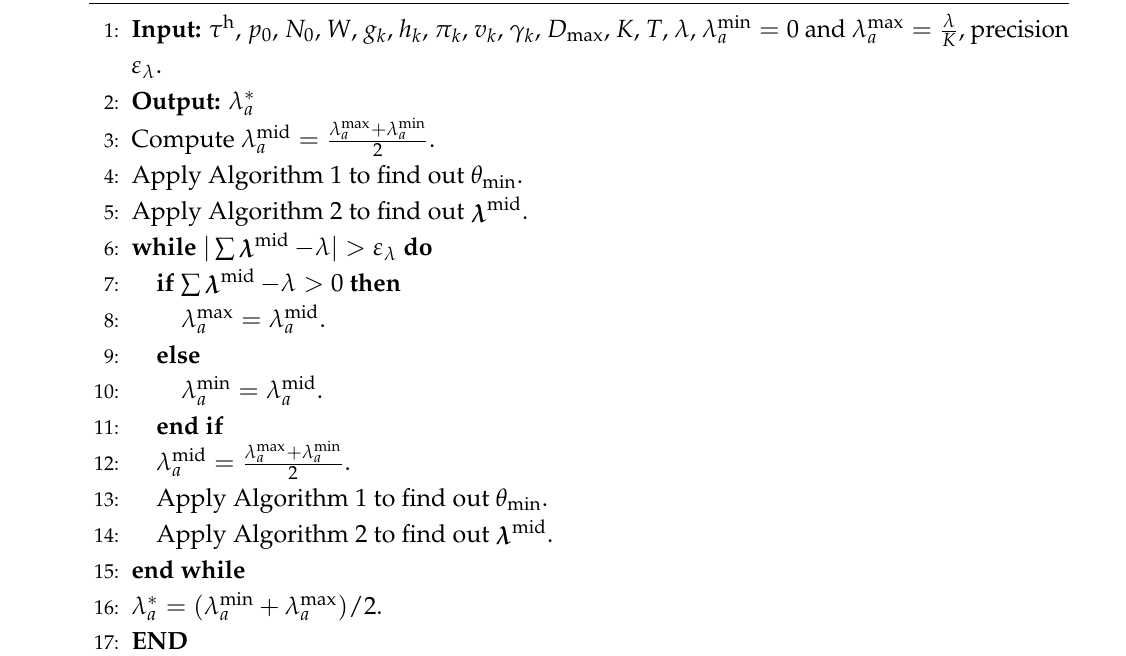
Algorithm 3 Find optimal λ ∗